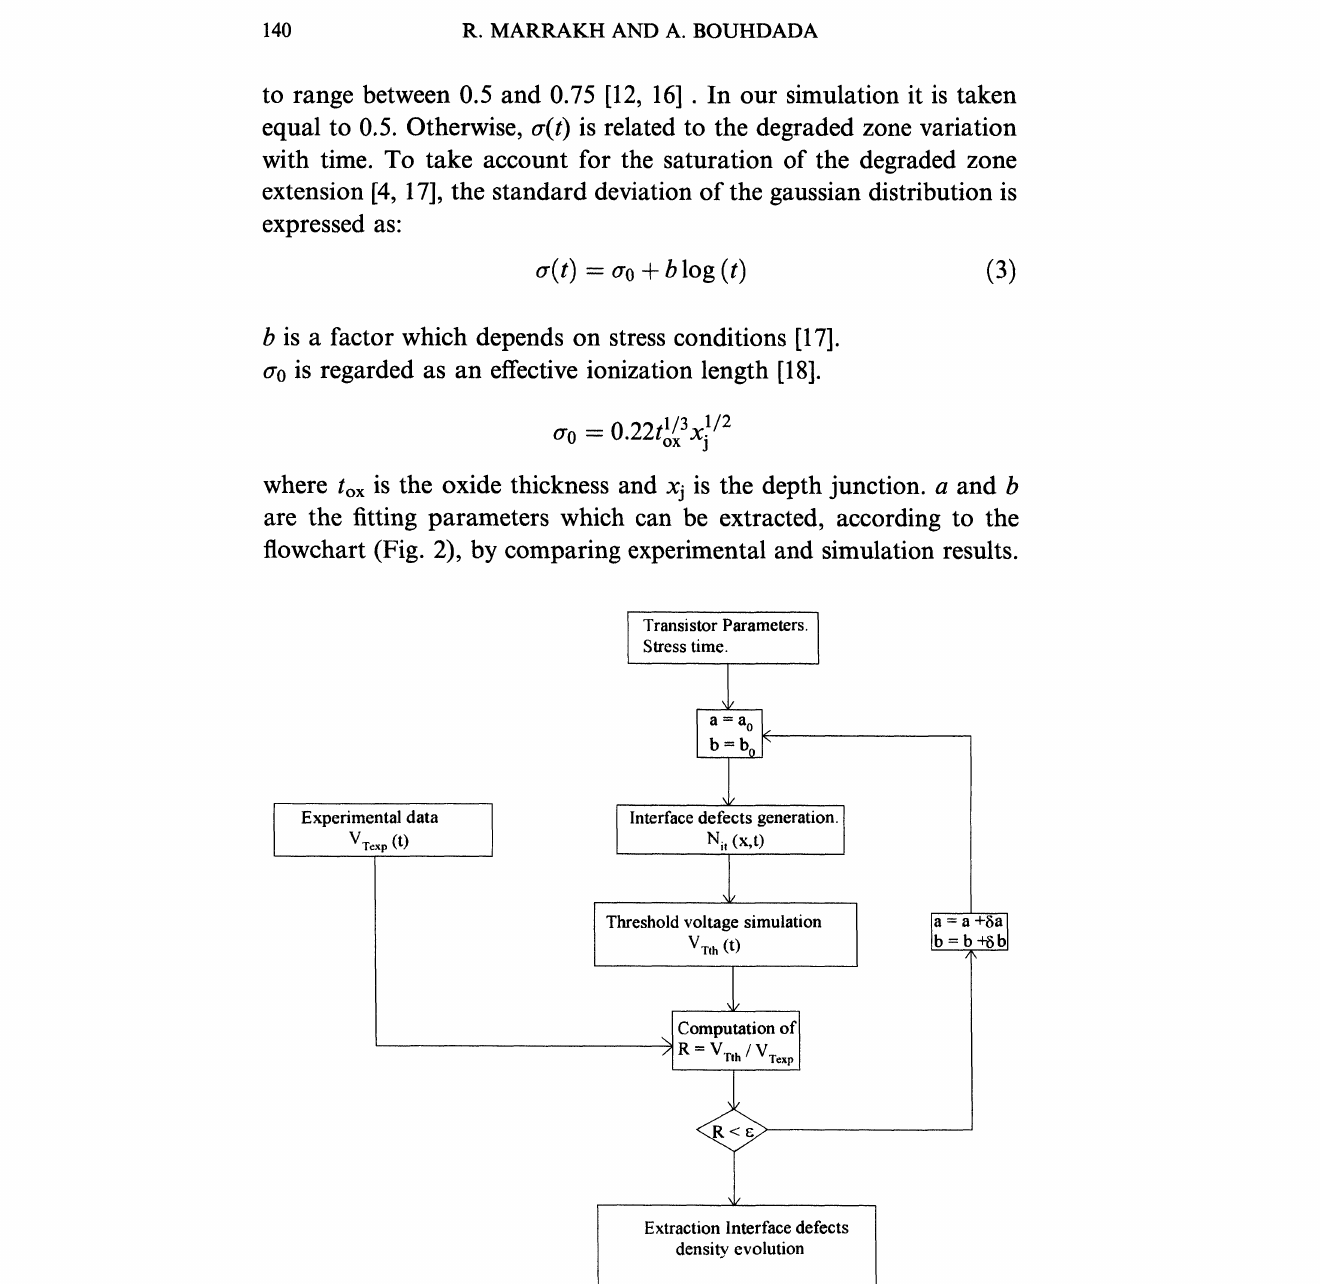
FIGURE 2 A flowchart showing the extraction of interface defects density